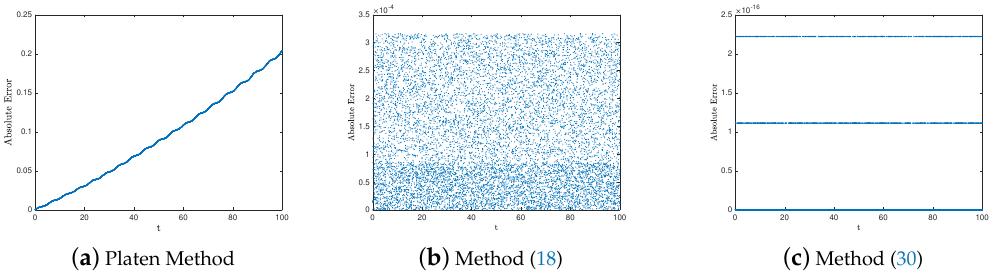
Figure 8. Conserved quantity errors of the Platen method, method (18), and method